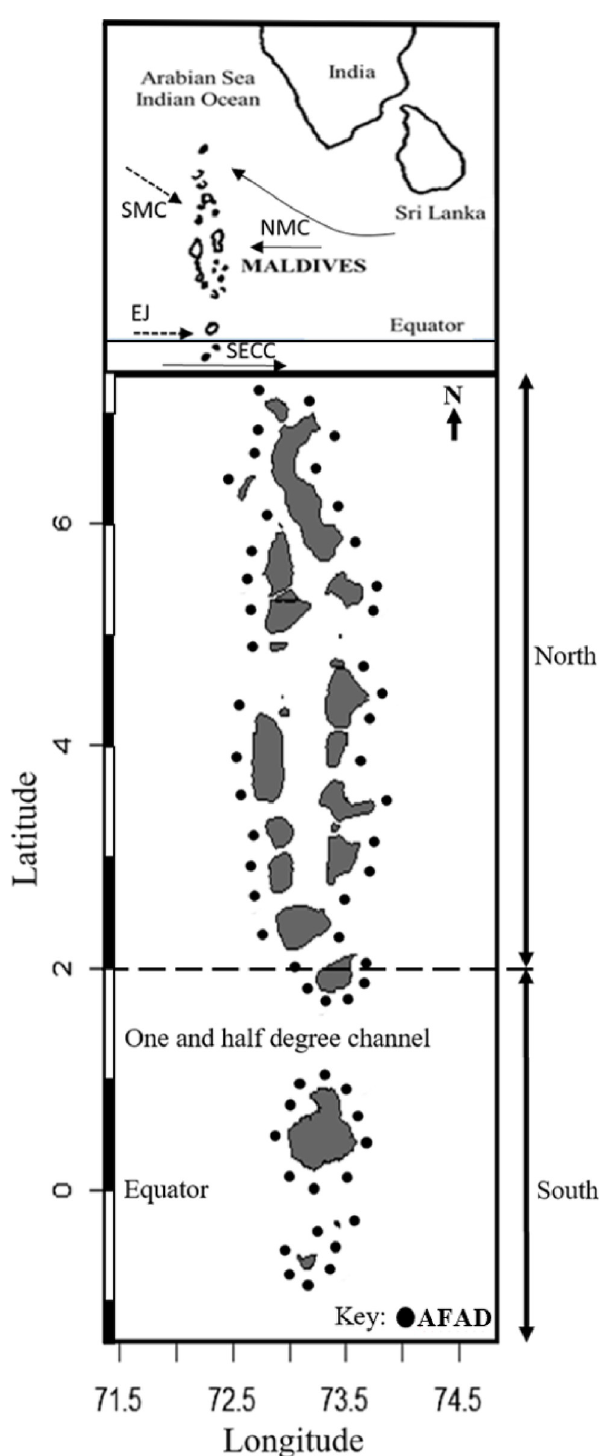
Fig 1. The study area, AFAD network outside Maldives atolls and the direction of monsoon related currents. (Dotted arrows indicate southwest monsoon currents and the continuous arrows indication northeast monsoon currents. NMC–northeast monsoon current, SECC–south equatorial counter current, SMC–southwest monsoon current, EJ–equatorial jet).